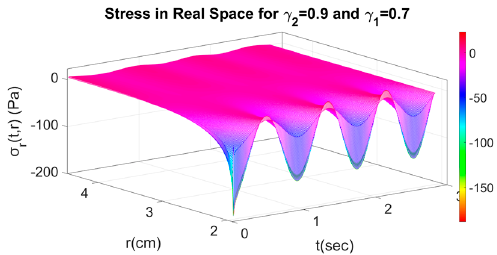
Figure 14. Distribution of the radial stress σ r ( t , r ) in the initial space with space (porosity) fractional order γ 1 = 0.7 and time fractional order γ 2 = 0.9.